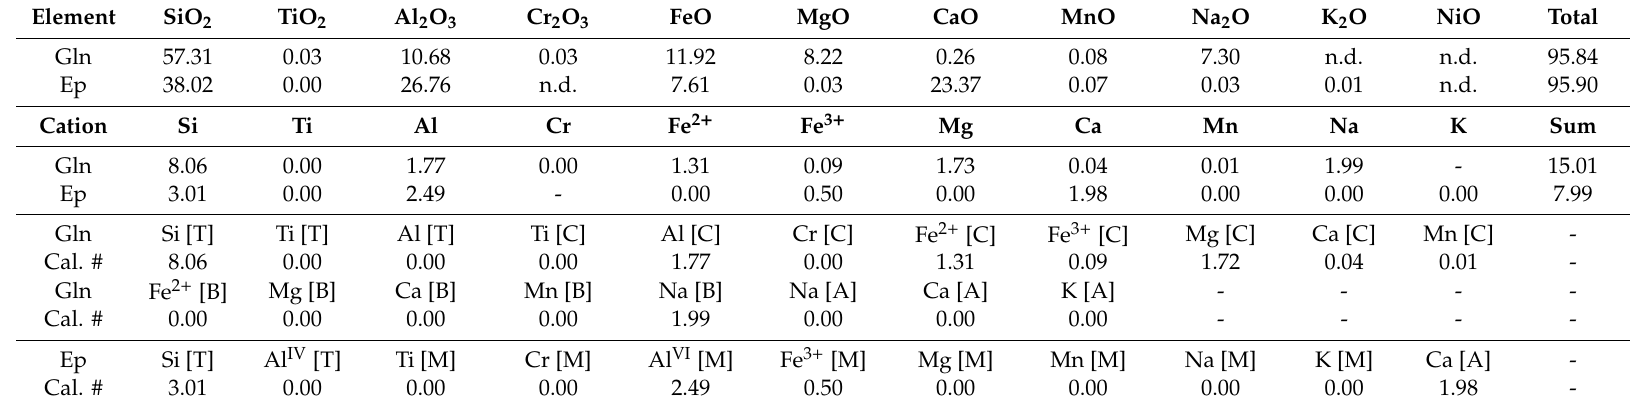
Table 1. The representative composition of glaucophane and epidote in the starting